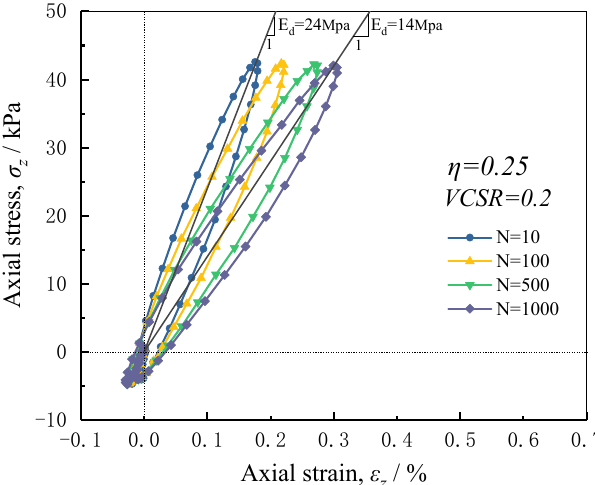
Figure 11. Comparison of typical stress–strain hysteresis curves at different cycles.